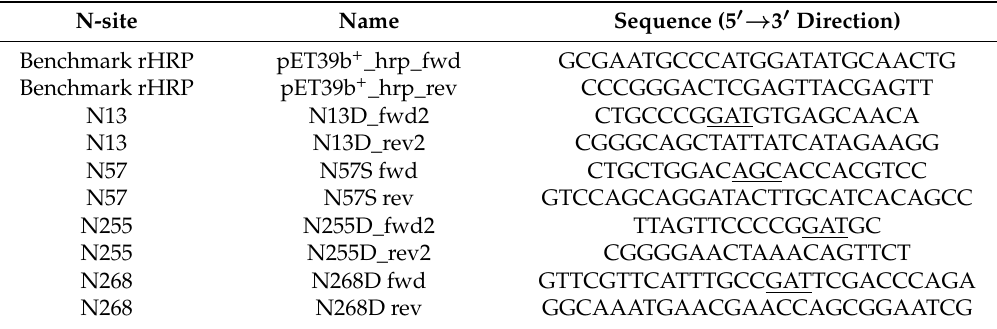
Table 7. Oligonucleotide primers to mutate four Asn residues that act as N -glycosylation sites to either Asp or Ser.